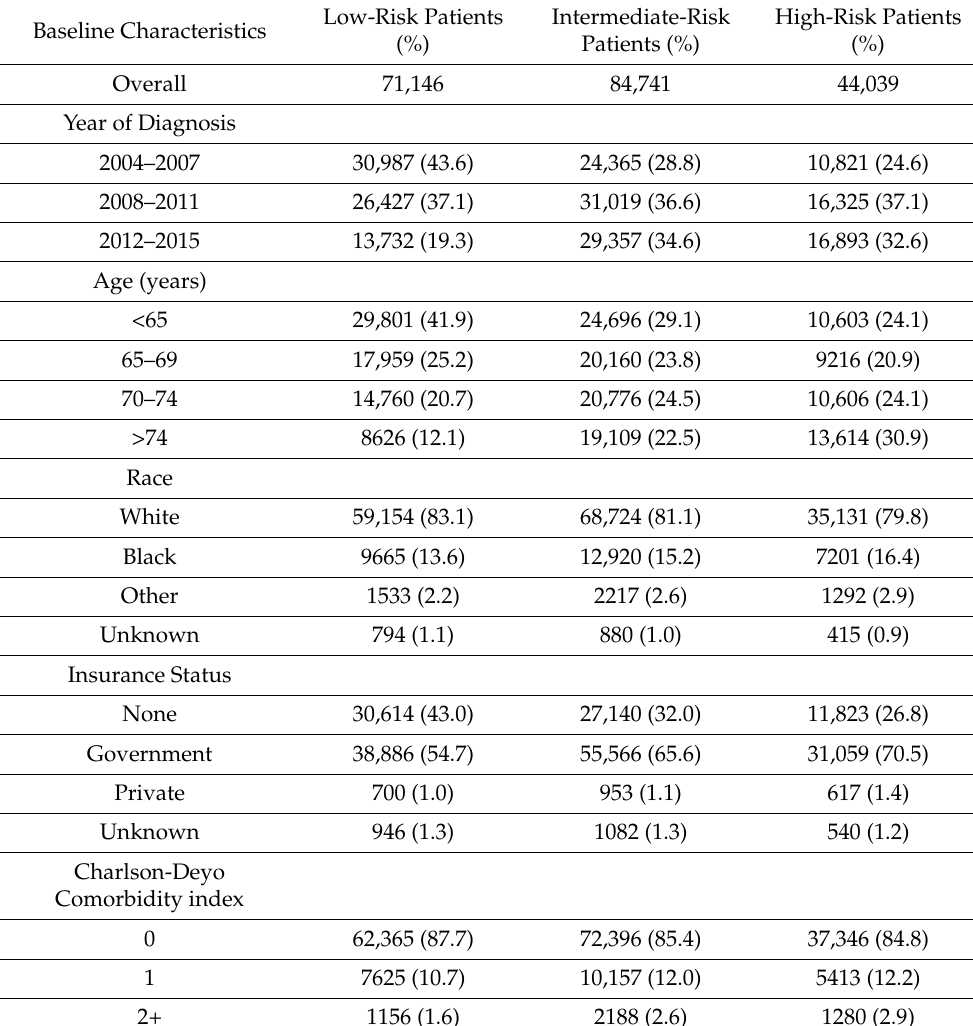
Table 2. Baseline characteristics of all patients with low-risk, intermediate-risk, and high-risk prostate cancer who received the research